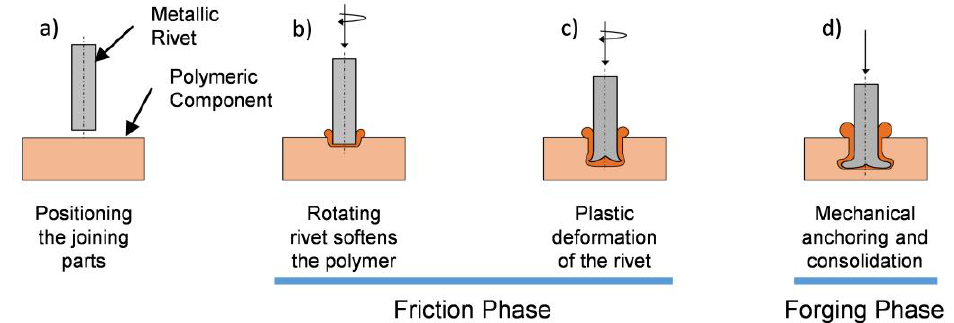
Figure 1. Schematics of the FricRiveting process using its basic configuration (metallic-insert joint geometry): ( a ) pre-joining configuration; ( b ) initial softened/molten polymer layer is formed; ( c ) plastic deformation starts; and ( d ) final deformation is achieved.